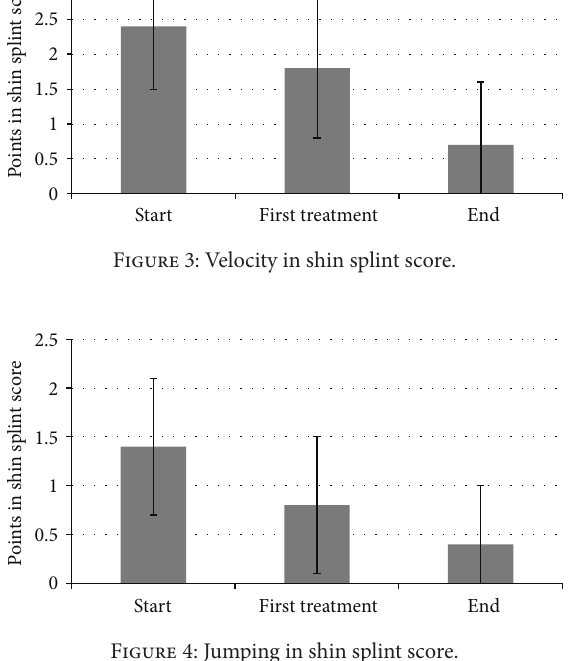
Figure 4: Jumping in shin splint score.